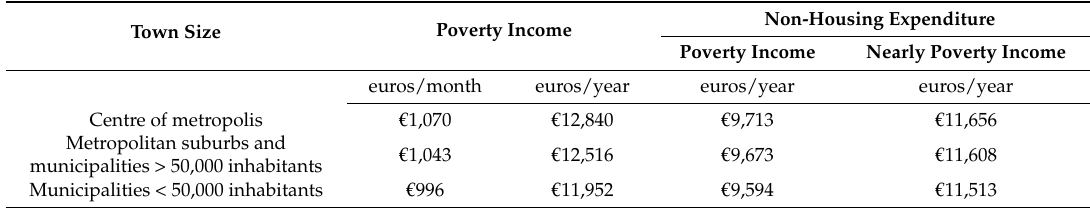
Table 1. Poverty threshold and non-housing expenditure of a family of two adults (from 18 to 59 years old) and one child (from four to 10 years old) in 2015 (our elaboration on ISTAT data).